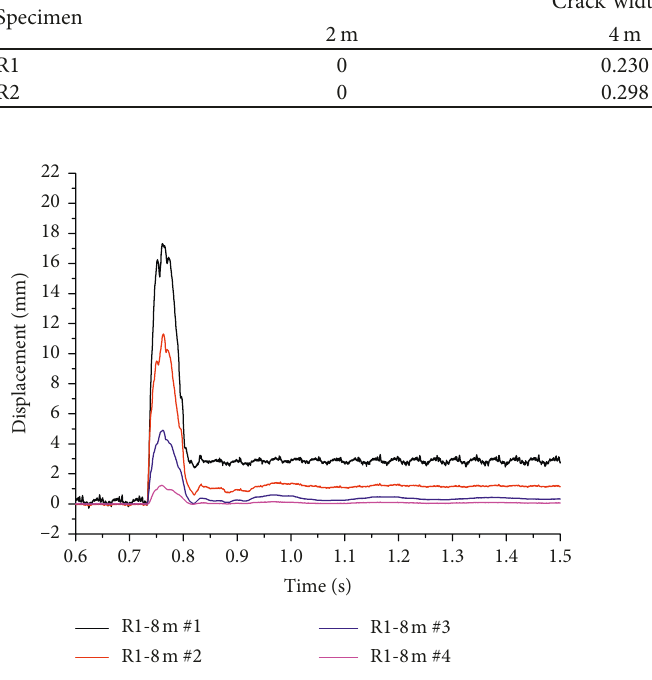
Figure 7: Displacement history of R1-8 m. Figure 8: Displacement history of